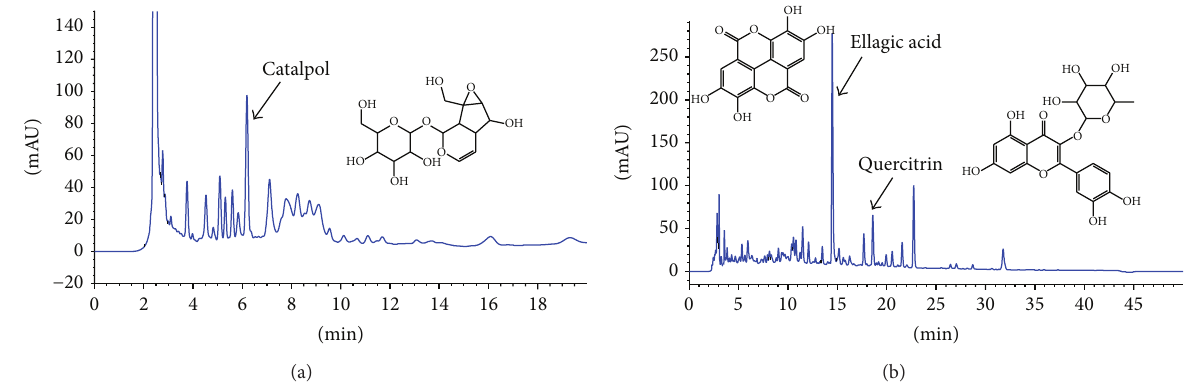
Figure 8: Typical HPLC chromatograms of CP001 for (a) catalpol, (b) ellagic acid, and quercitrin.